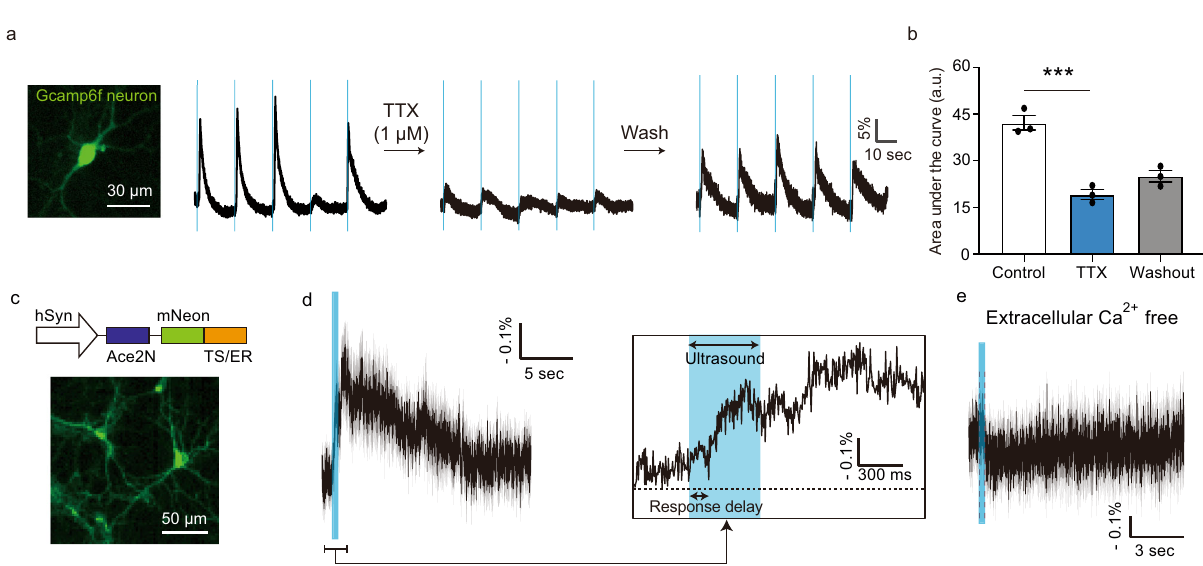
Fig. 3 Ultrasound response is mediated by the entry of extracellular calcium. a Calcium responses from a single neuron during ultrasound stimulation before, during and after treatment with the sodium channels blocker tetrodotoxin (TTX). b Quanti fi cation of area under the curve before, during and after TTX treatment ( n = 3 independent experiments, one-way ANOVA p = 0.0004, Tukey ’ s post comparison (control vs. TTX)). c Diagram of the Ace2N voltage indicator genetic construct and representative fl uorescence image of neurons transfected with this construct. d Voltage responses to ultrasound. ( n = 4 independent experiments). e Voltage responses of neurons in calcium-free media ( n = 2 independent experiments). Mean trace is solid and SEM is shaded. Bar graph values represent mean ±